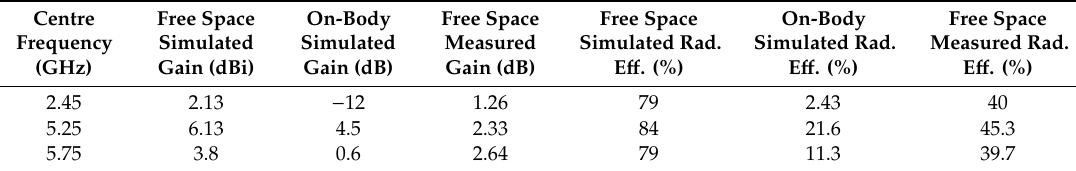
On-body and o ff -body comparison of simulated and measured antenna gain and radiation e ffi ciency.